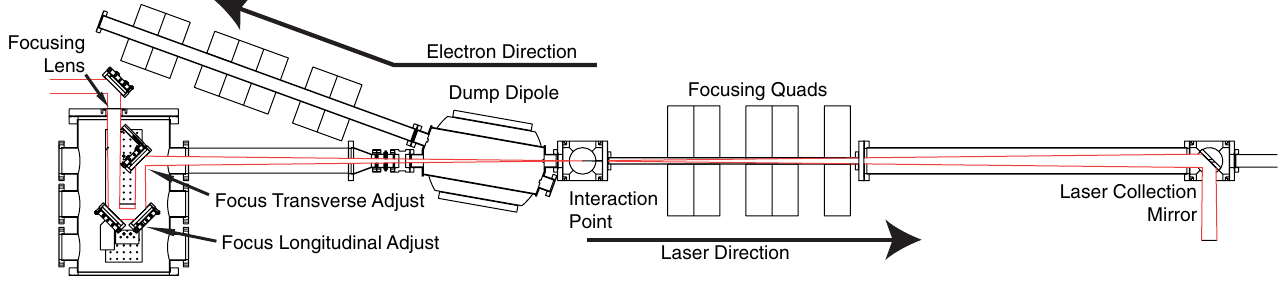
FIG. 8. (Color) Layout of the T-REX interaction region.